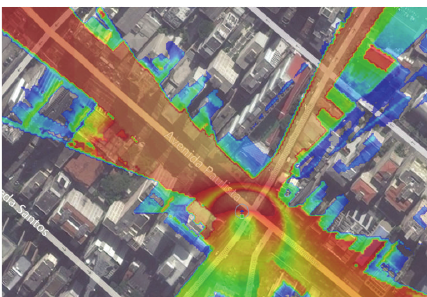
Figure 2: Simulation of a BS located in downtown of S˜ao Paulo. Buildings in both sides of the streets block the EMF propagation. However, directions with fewer blockages present stronger EMF signals, even for back radiation of the antenna.